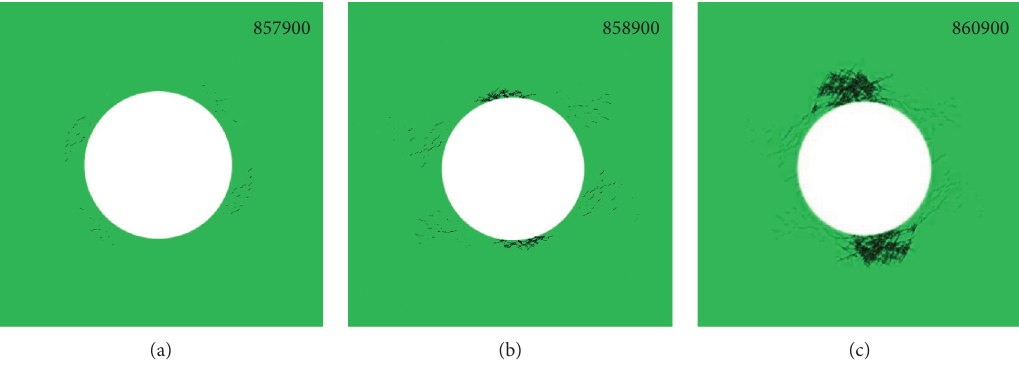
Figure 11: The simulated crack propagation process in studying excavation effects.